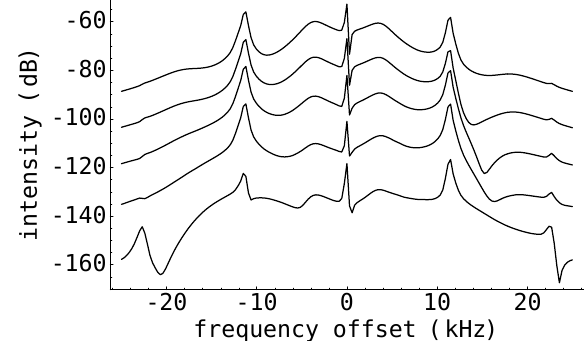
FIG. 10. Simulated beam response functions T 9 55 , T 18 55 , T 36 55 , T 55 55 , and T 135 55 (top to bottom) for a fully stretched 300 mA bunch in the VUV ring. Realistically detuned main- cavity and harmonic-cavity impedances are included in the simulation. The vertical scale has an arbitrary scale factor. Machine parameters are given in Table